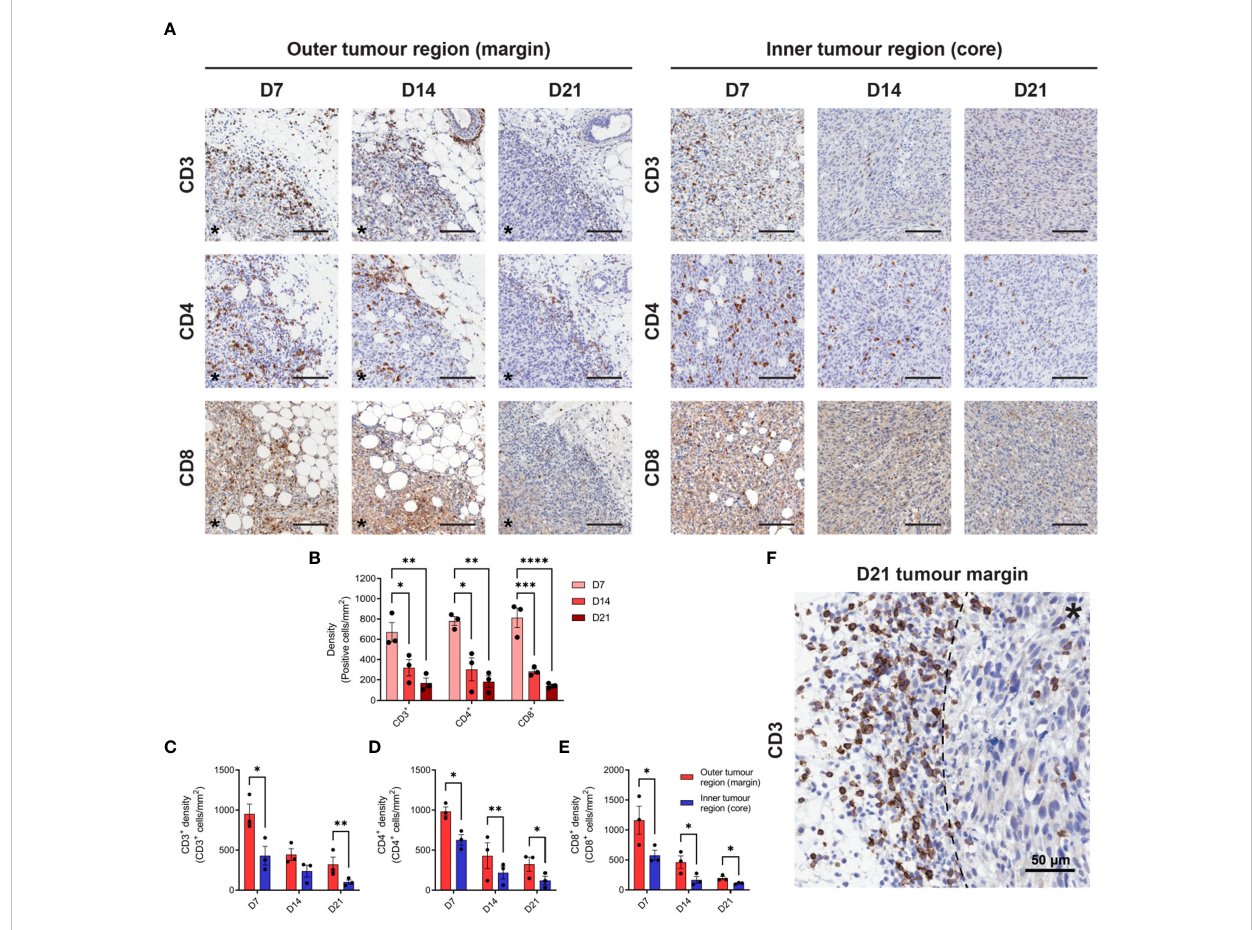
FIGURE 2 T cell in fi ltration in MC38 tumours during progressive outgrowth. (A) MC38 tumours were resected from mice 7-, 14- and 21-days post-inoculation (n = 3 biological replicates per timepoint) and processed for IHC. Images depict immunohistochemical staining for CD3, CD4, or CD8 (DAB, brown with haematoxylin counterstain) in the outer (left panel) and inner (right panel) regions of MC38 tumours (D7, D14 and D21). All scale bars depict 100 m m. (B) Quanti fi cation of CD3, CD4, and CD8 in fi ltration in MC38 tumours (total tumour area) during progressive outgrowth. (C – E) Quanti fi cation of CD3 (C) , CD4 (D) , and CD8 (E) in fi ltration in the outer and inner regions of MC38 tumours at indicated timepoints. CD3 + , CD4 + , and CD8 + density was quanti fi ed as the absolute number of positive cells per mm 2 (positive cells/mm 2 ). (F) Representative image depicting dense accumulation of CD3 + cells at the stromal – tumour interface (dashed line) in late-stage D21 tumours. Asterisks (*) denote the side of the tumour in images of the tumour margin. Graphs represent the mean and standard error of the mean (SEM, error bars). Statistical analyses were performed using one-way ANOVA with post-hoc Tukey test to correct for multiple comparisons (B) or two-tailed paired Student ’ s t-tests (C – E) . *p ≤ 0.05; **p ≤ 0.01; ***p ≤ 0.001; ****p ≤